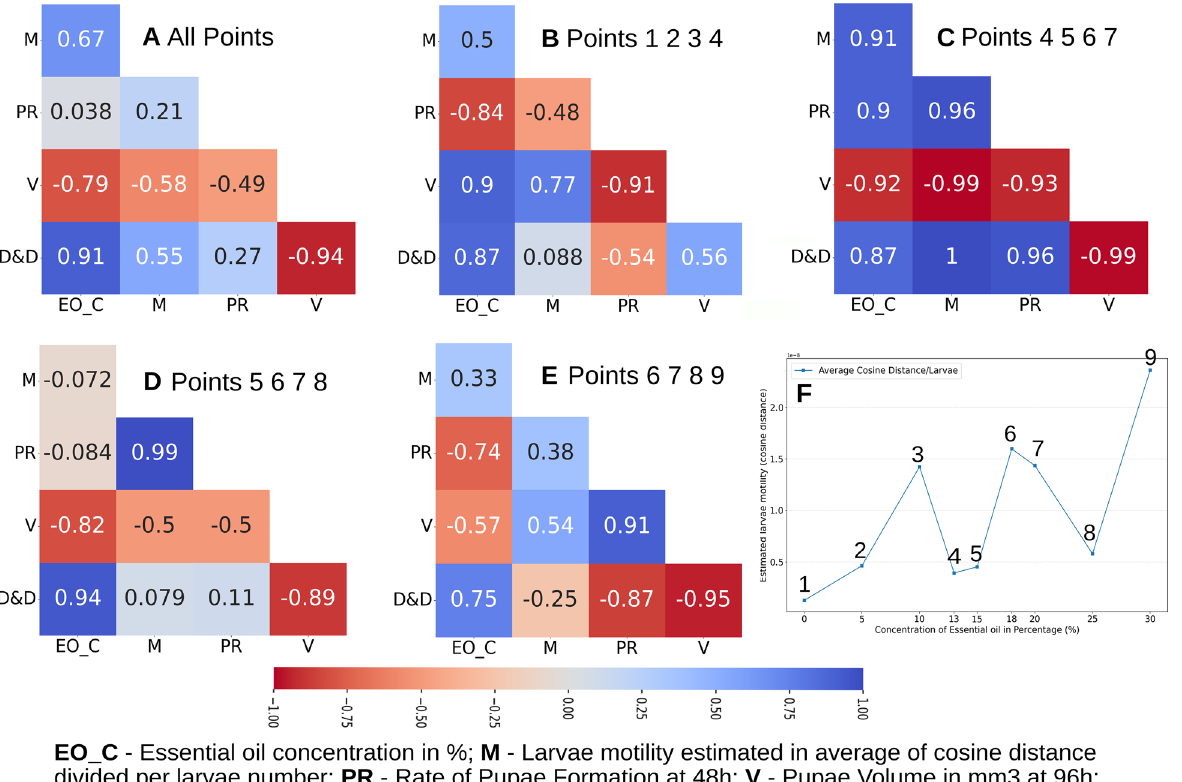
of adult flies hatched deformed and dead considering the points among ( A ) EO concentrations 0 to 30%; ( B ) EO concentrations 0 to 13%; ( C ) EO concentrations 13 to 20%; ( D ) EO concentrations 15 to 25%; ( E )